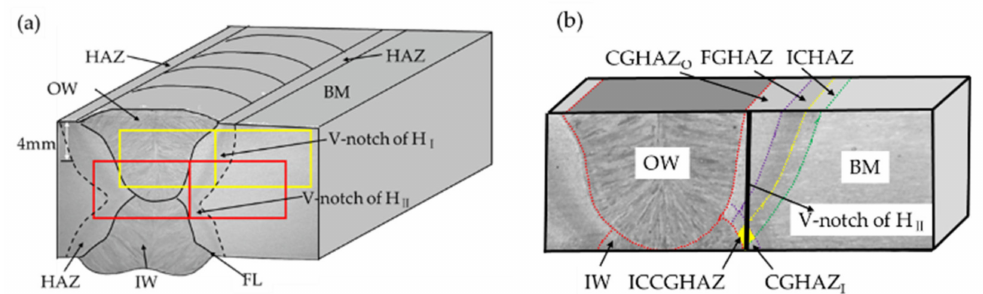
Figure 2. ( a ) the location of the V-notch of the two groups; ( b ) the detail of the V-notch in